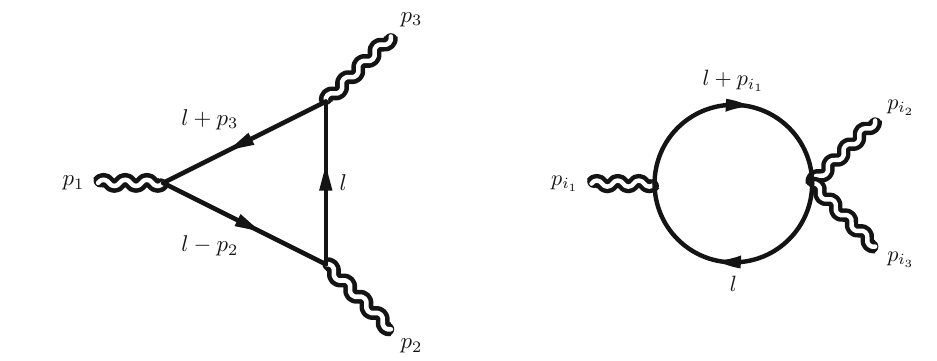
Fig. 3 The topologies contributing to the < TTT > correlation function. All the external momenta are incoming